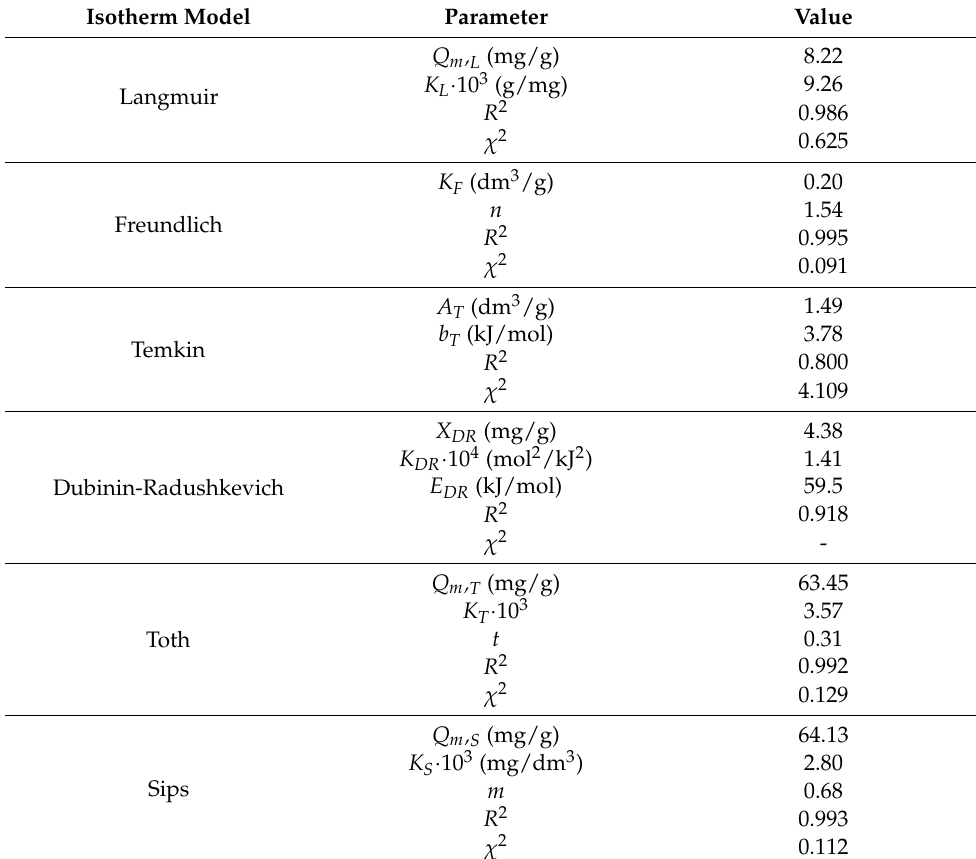
Table 3. Parameters and error function data for isotherm models obtained by nonlinear fitting for the chromium sorption onto Fe 3 O 4